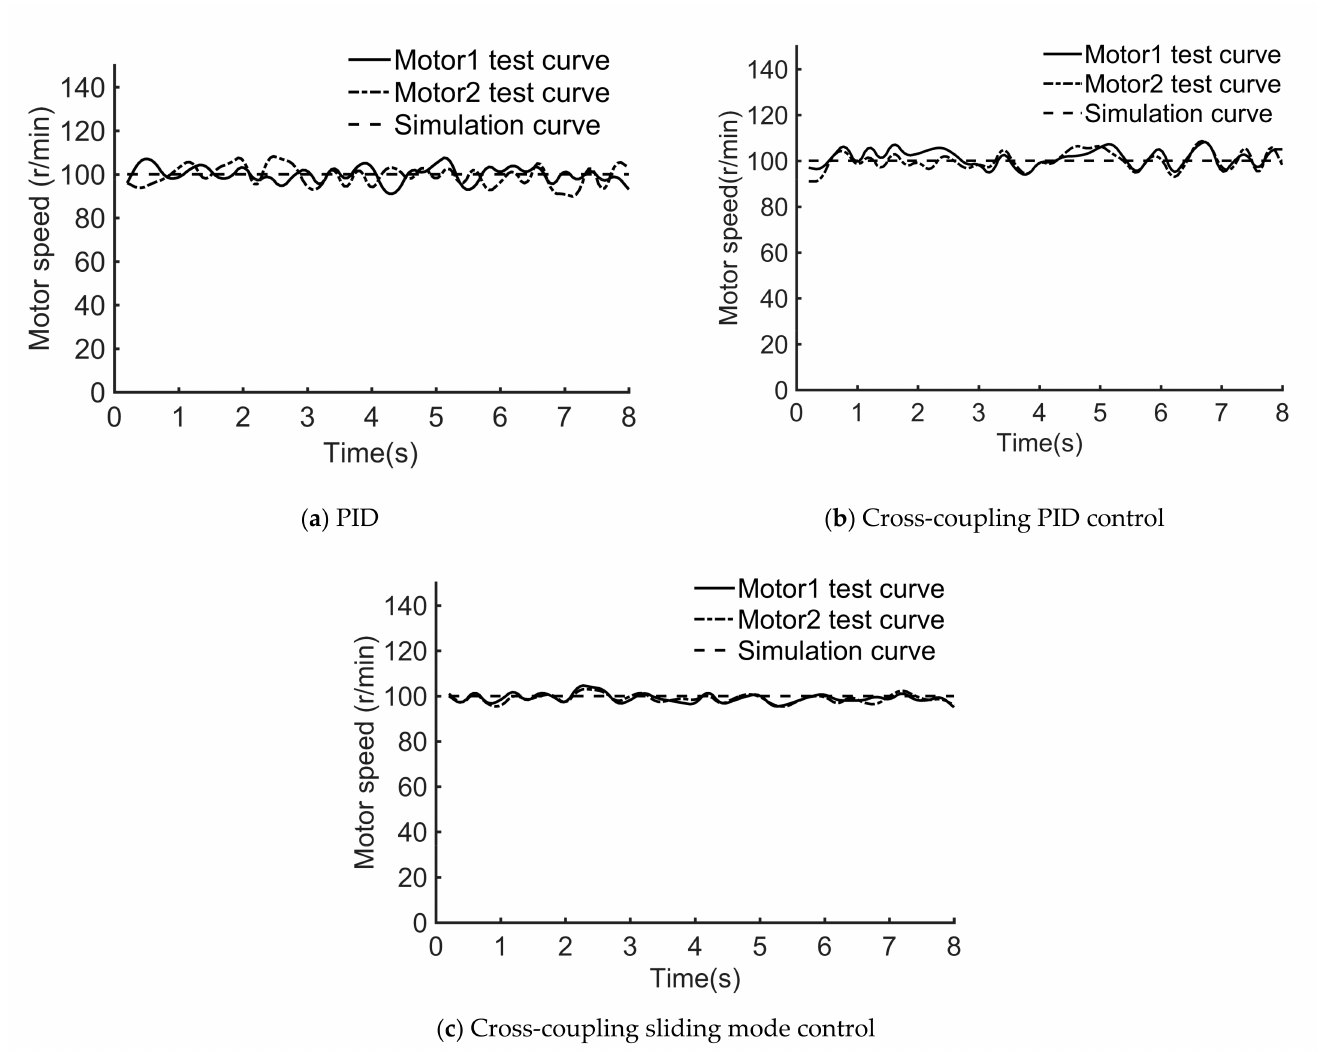
Figure 7. Synchronous Output Curve of Double-channel Motor Speed.